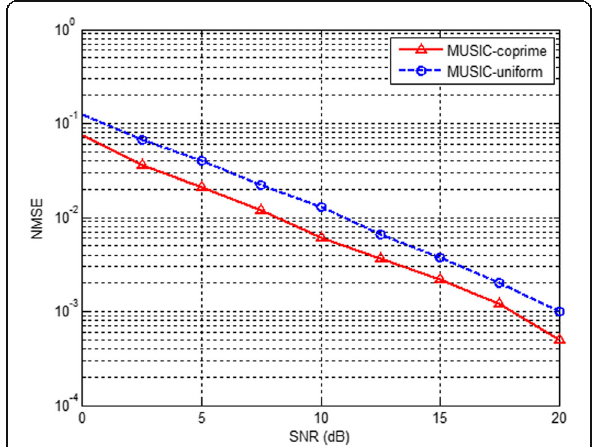
Fig. 7 The NMSE under same method versus SNR when different arrays. It compares the estimated performance of the same channel